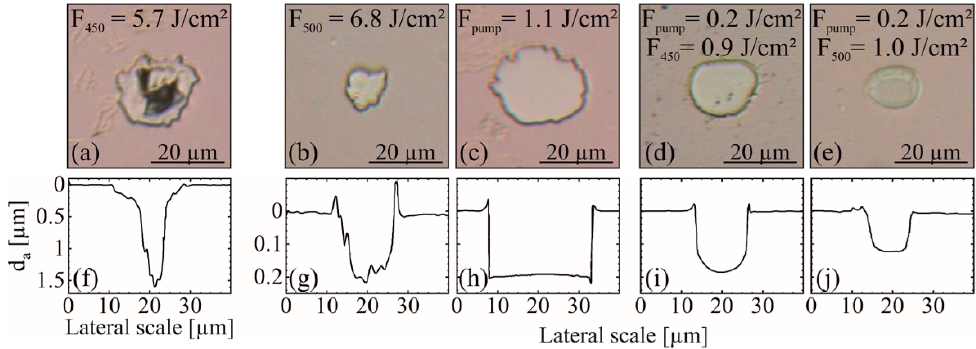
Figure 4. Microscopic images of single-beam ablation spots with ( a ) F 450 = 5.7 J/cm², ( b ) F 500 = 6.8 J/cm², and ( c ) F pump = 1.1 J/cm², as well as ESA-based dual-beam ablation spots at ( d ) Δ t = 5 ns with F pump = 0.2 J/cm² + F 450 = 0.9 J/cm² and ( e ) Δ t = 10 ns with F pump = 0.2 J/cm² + F 500 = 1.0 J/cm². ( f – j ) White light interferometric depth profiles of spots ( a – e ).